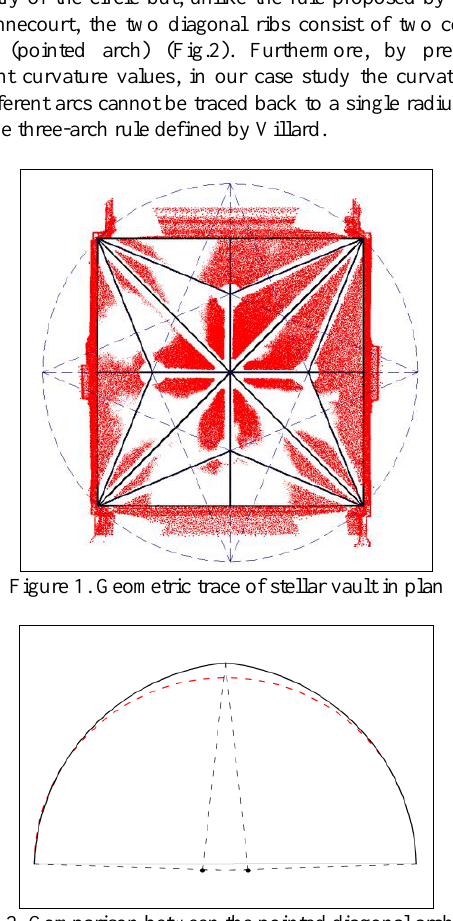
Figure 2. Comparison between the pointed diagonal arch of the stellar vault in Santa Maria del Monte (black) and the theoretical round diagonal arch.